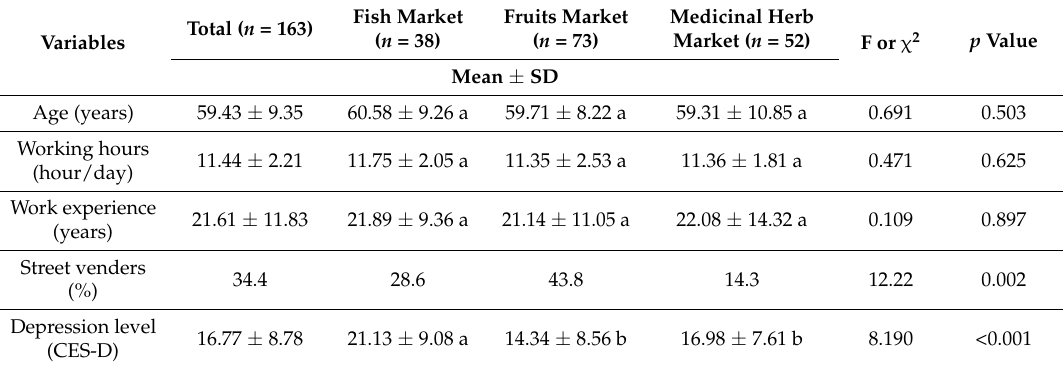
Table 3. General characteristics and depression level of workers in the traditional